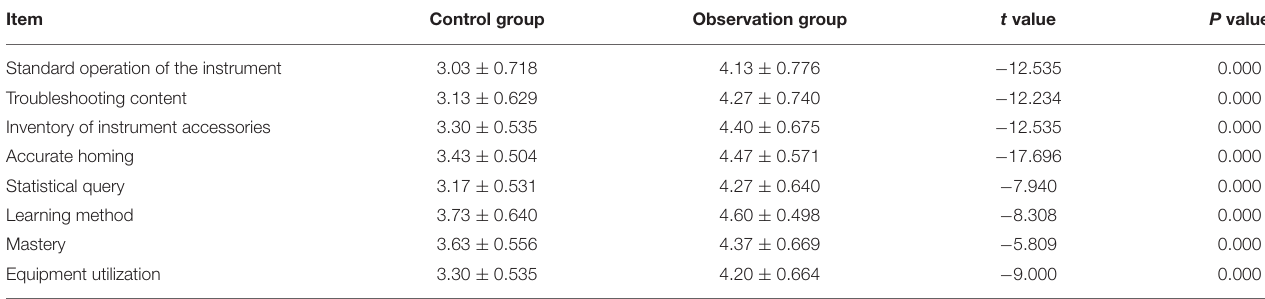
TABLE 1 | Comparison of nurses’ satisfaction with instrument management and training between the two groups (points, X ± S).